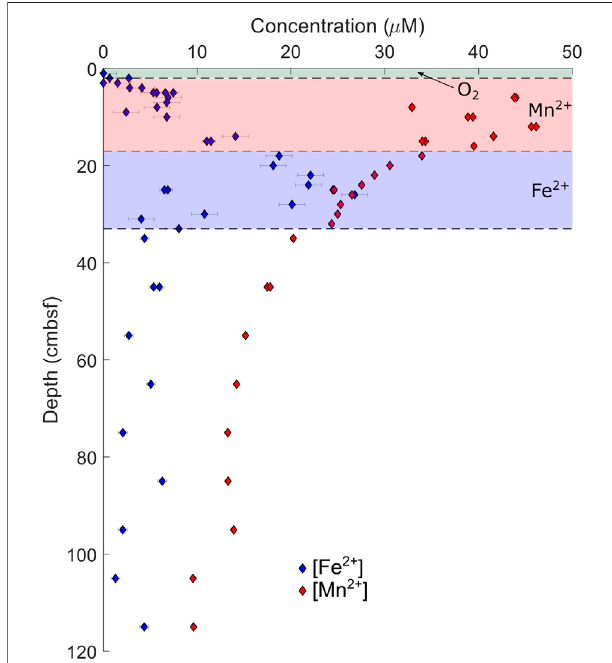
FIGURE 5| Pore fl uid iron and manganese concentrations from AQ700, with overlying “ zones ” as interpreted by the relative depths of the recorded maximum of each